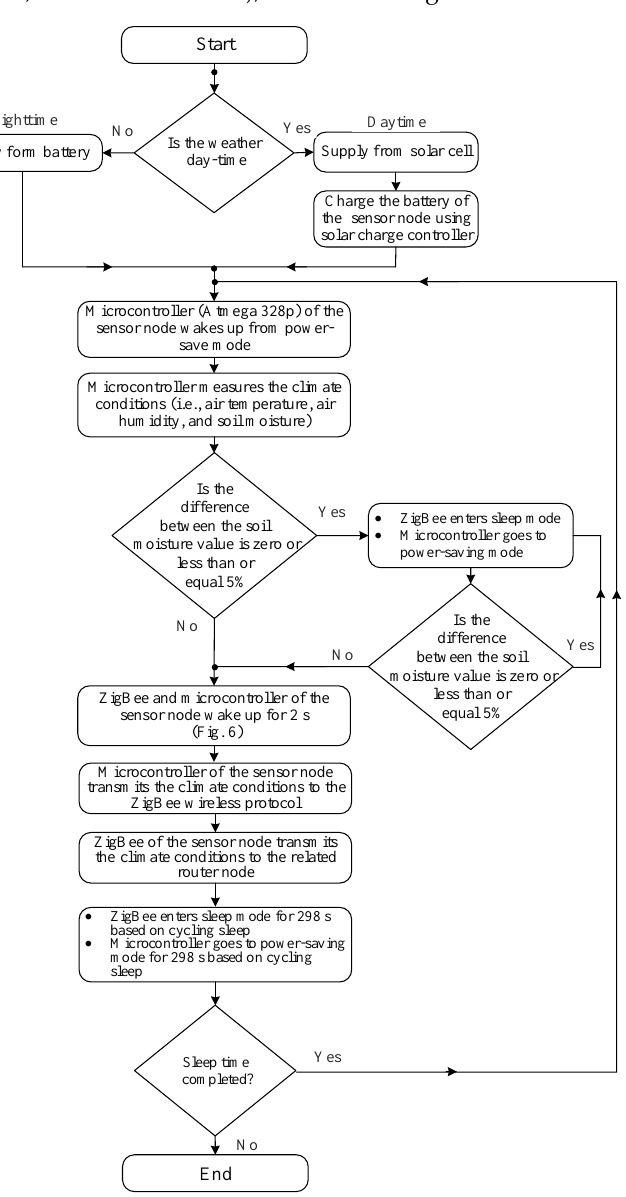
Figure 5. Flow diagram of the SWORD algorithm.